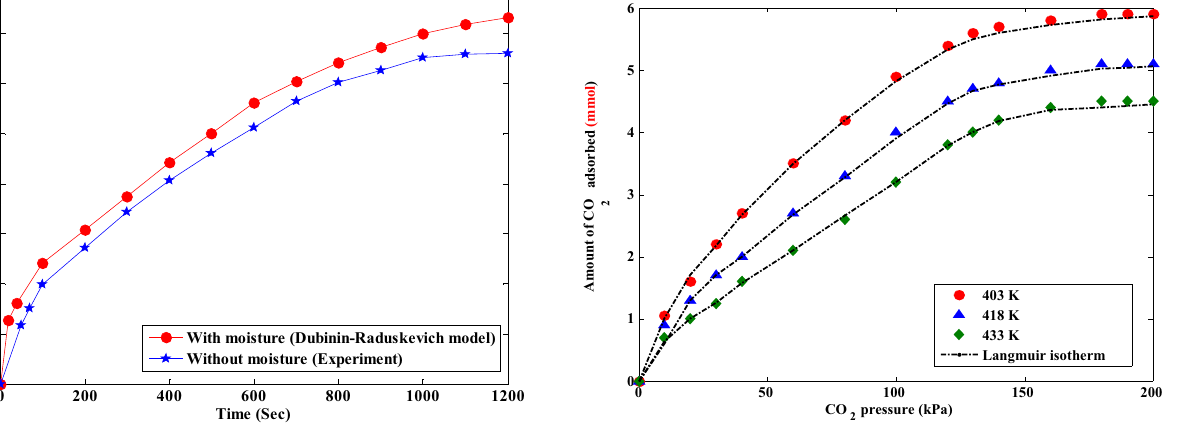
Fig. 3 CO 2 adsorption isotherms of polyaspartamide at various temperatures (experimental vs Langmuir